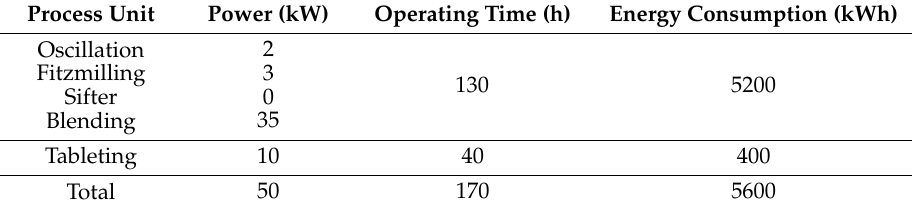
Table 1. Summary of baseline pharmaceutical tablet process units‘ data per batch.